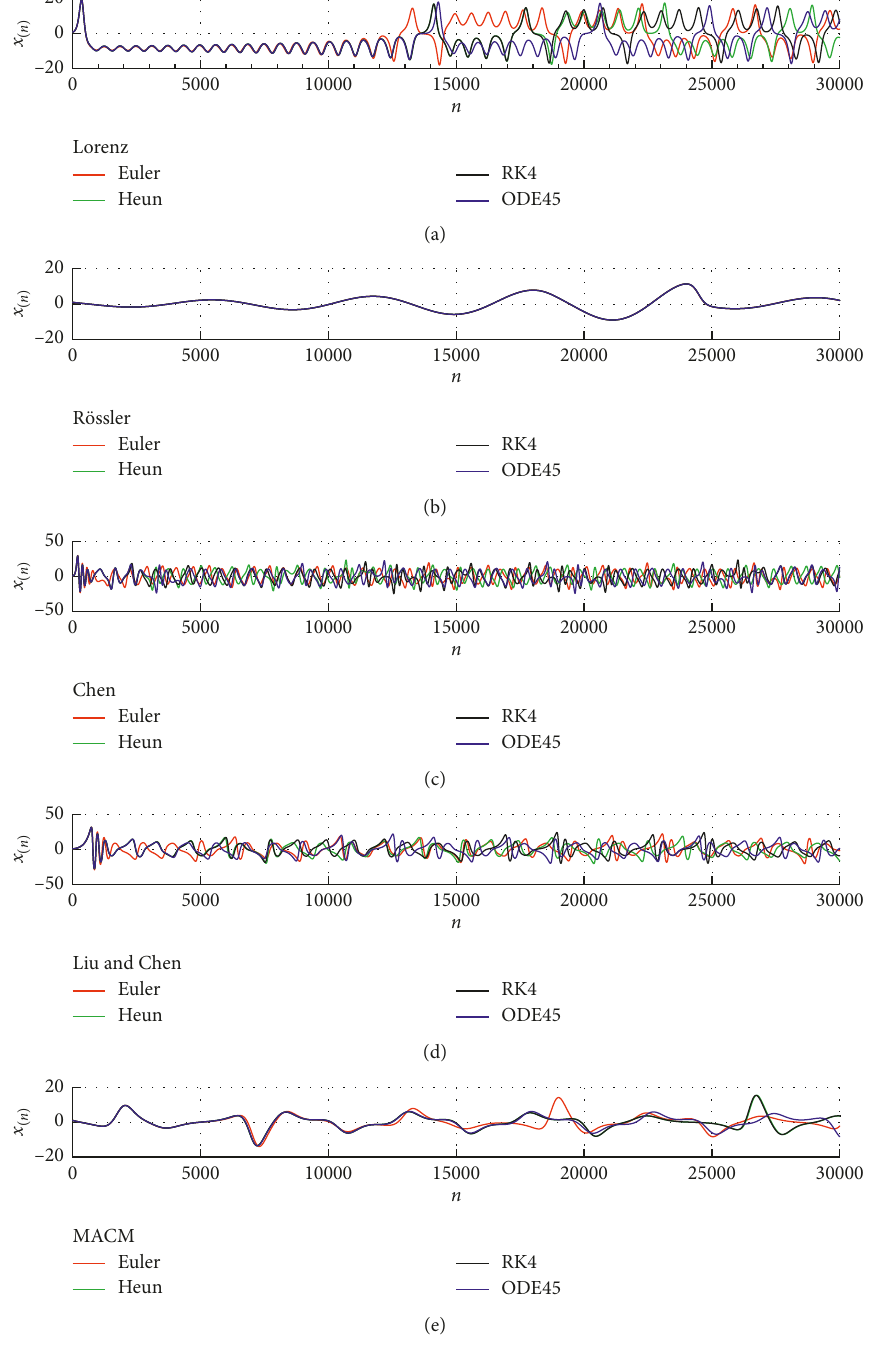
Figure 2: Evolution of state variable x ( n ) of the CSs: (a) Lorenz (2), (b) R¨ossler (2), (c) Chen (3), (d) Liu and Chen (4), and (e) MACM (5) in their CVs with respect to their DVs by using the NAs of Euler (6), Heun (7)–(8), and RK4